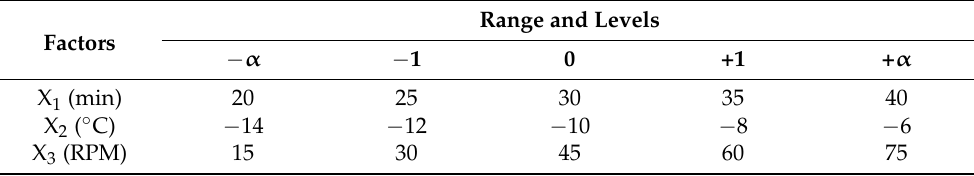
Table 1. Range and coded